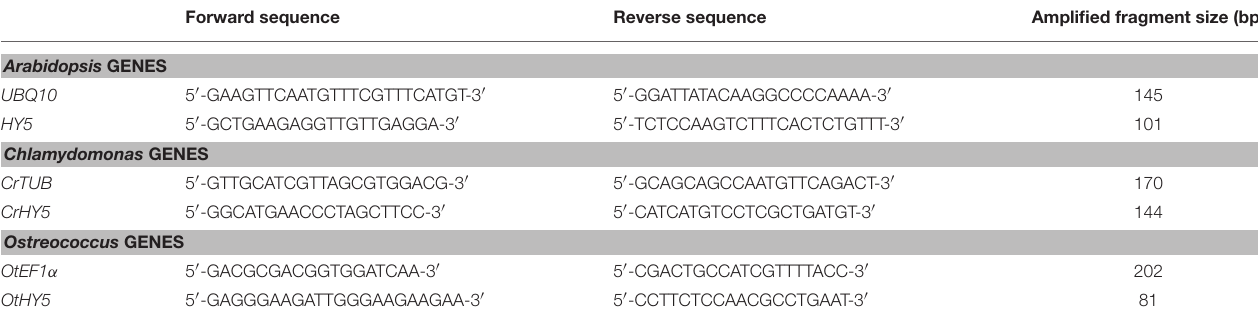
TABLE 1 | Primers employed in QPCR